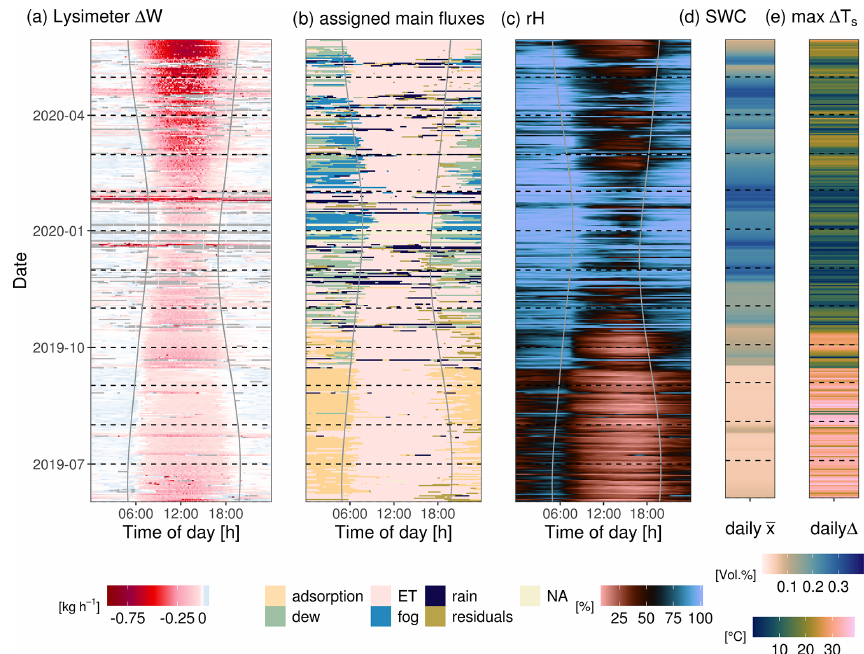
Figure 2. Diel and seasonal dynamics of (a) lysimeter weight changes, (b) assigned flux types, both from lysimeter 6, and (c) RH measured at 1m height. Solid vertical lines mark sunrise and sunset, respectively, determined with the geographic coordinates of the field site. Mean SWC at 0.05m depth and maximum diel difference in T s are displayed as diel measurements in panels (d) and (e)